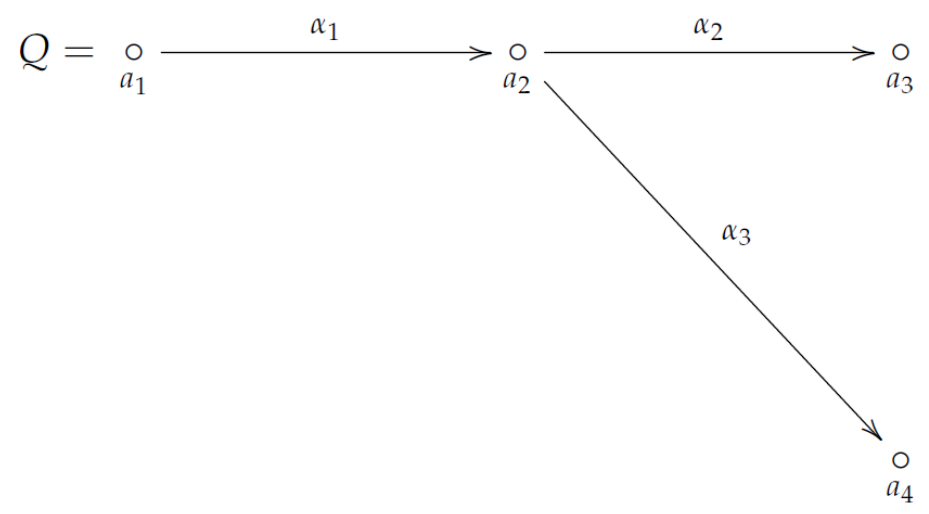
Figure 2. A quiver Q with four vertices and three arrows α 1 , α 2 , and α 3 , s ( α 2 ) = s ( α 3 ) = a 2 = t ( α 1 ) , s ( α 1 ) = a 1 , t ( α 2 ) = a 3 , and t ( α 3 ) = a 4